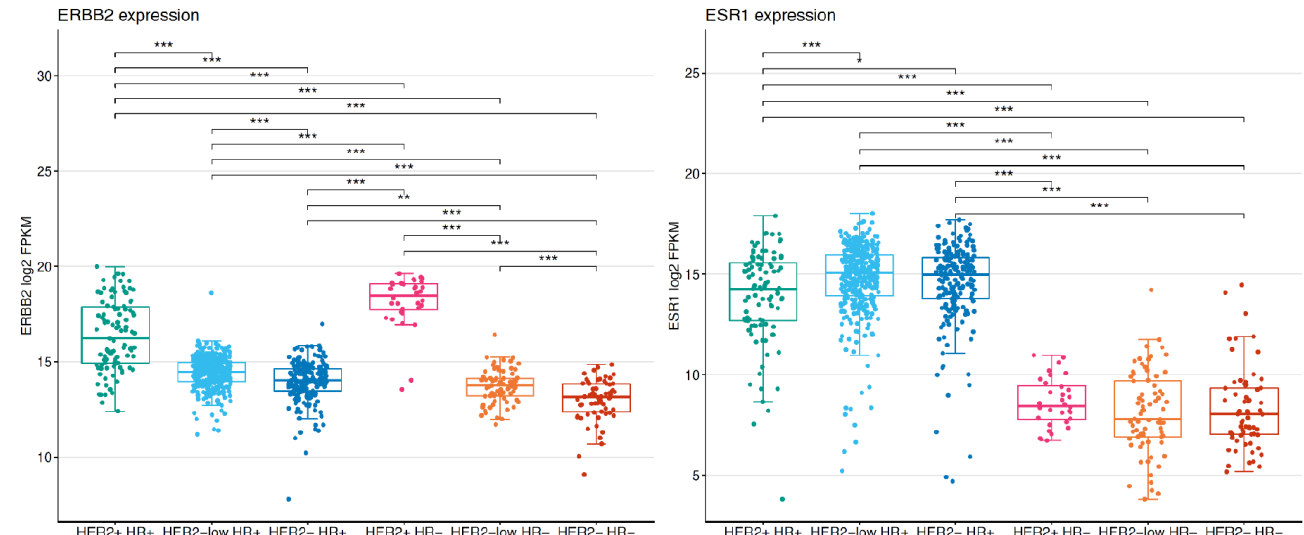
Figure 3. ERBB2 and ESR1 gene expression according to breast cancer subtypes ( n = 799). In the boxplots, the boxes are defined by the 25th to 75th percentiles; the median is shown as a bold colored horizontal line. Statistical differences were assessed using a two-sided Mann–Whitney U-test followed by Benjamin and Hochberg correction for multiple testing. FDRs < 0.05 are shown. Abbreviations: * 0.05 > adjusted p -value ≥ 0.01, ** 0.01 > adjusted p -value ≥ 0.001, *** adjusted p -value < 0.001, HR: hormone receptor.